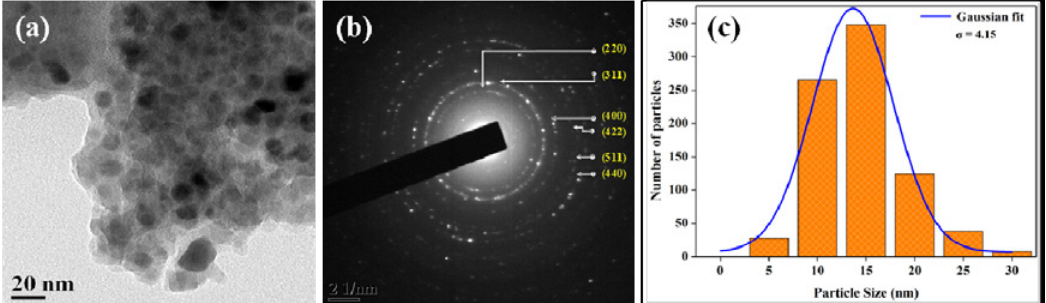
O @SiO NPs dispersed in silica matrix (b) SEAD 2 4 2